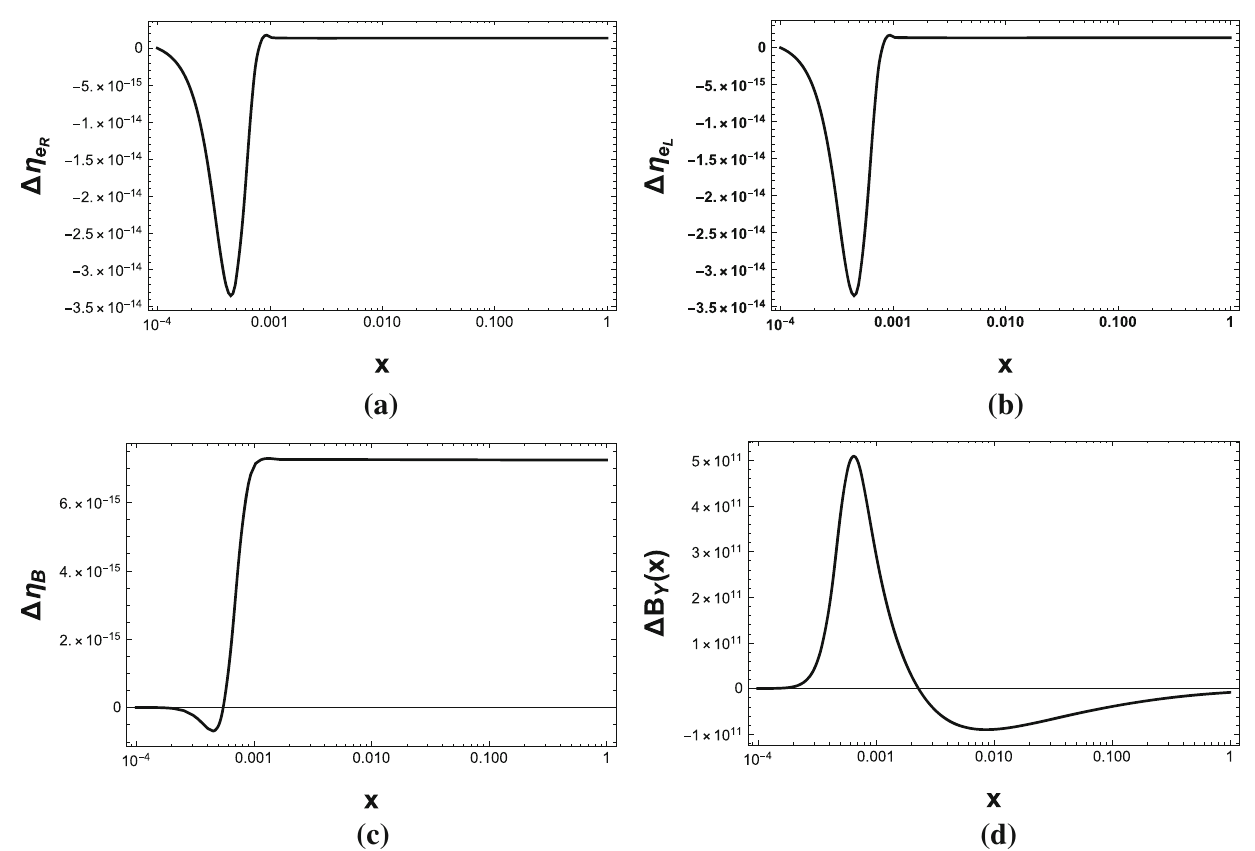
, c the baryon asymmetry (cid:8)η B , and d the hypermagnetic metry (cid:8)η e L field amplitude (cid:8) B Y . The initial conditions are: k = 10 − 7 , B